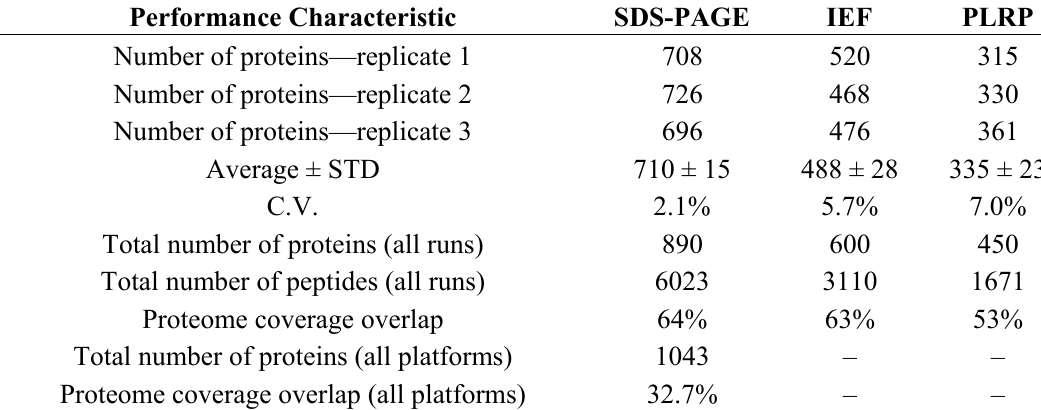
Table 1. Summary of the performance of three gel-based and gel-free bioanalytical platforms for mitochondrial proteome mapping.